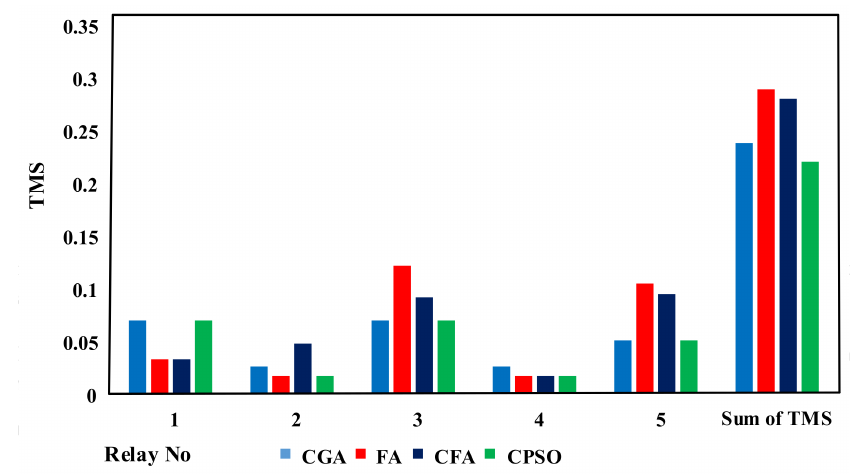
Figure 10. Graphical representation of the optimized TMS compared with the literature for Case III.